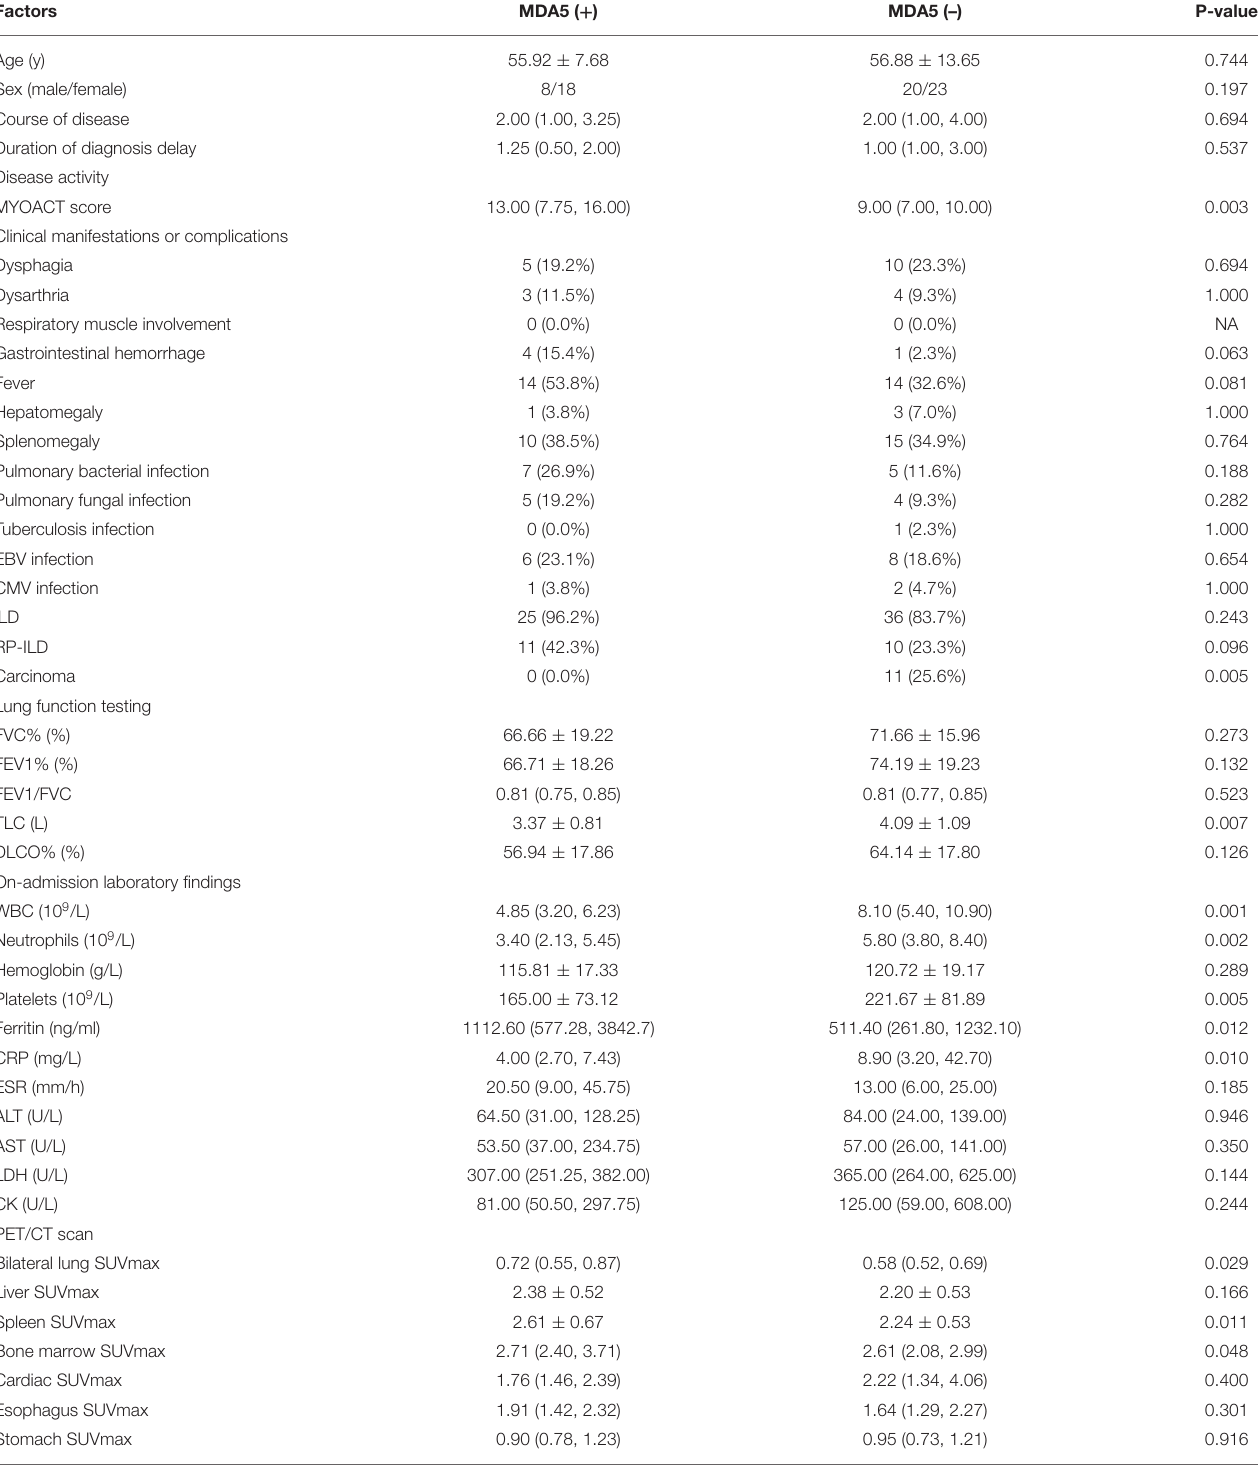
TABLE 1 | Comparison between the patients with idiopathic inflammatory myopathy (IIM) with or without positivity of anti-melanoma differentiation associated protein 5 (anti MDA5) antibody.